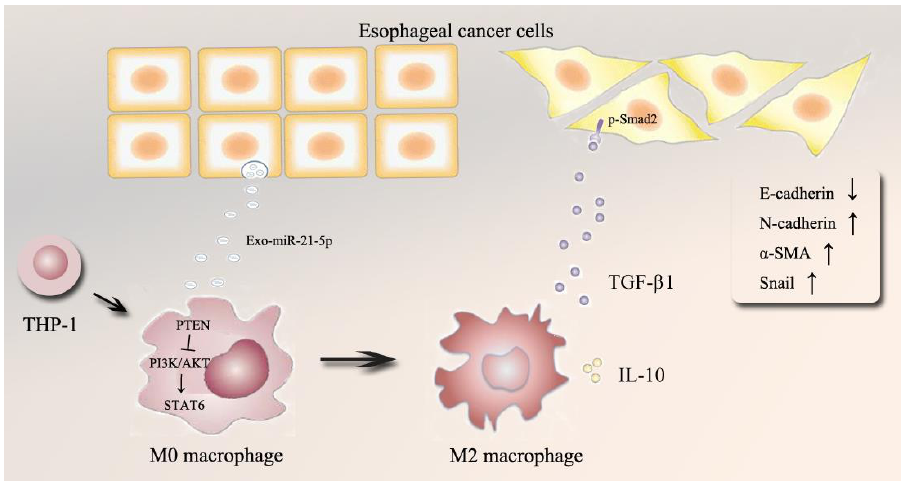
Figure 8. Schematic model of this study.